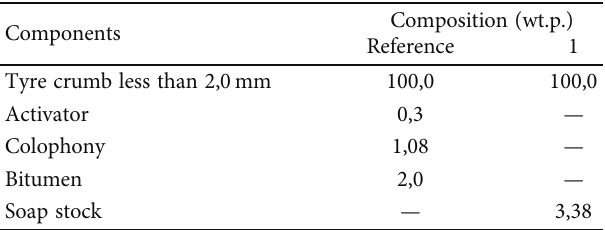
Table 1: The tyre reclaim composition (wt.p.).